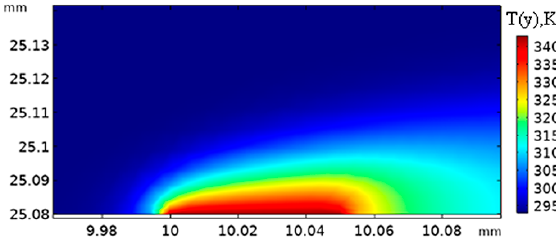
Figure 8. The temperature gradient of a dual-layer hot-film sensor at τ = 5 Pa.